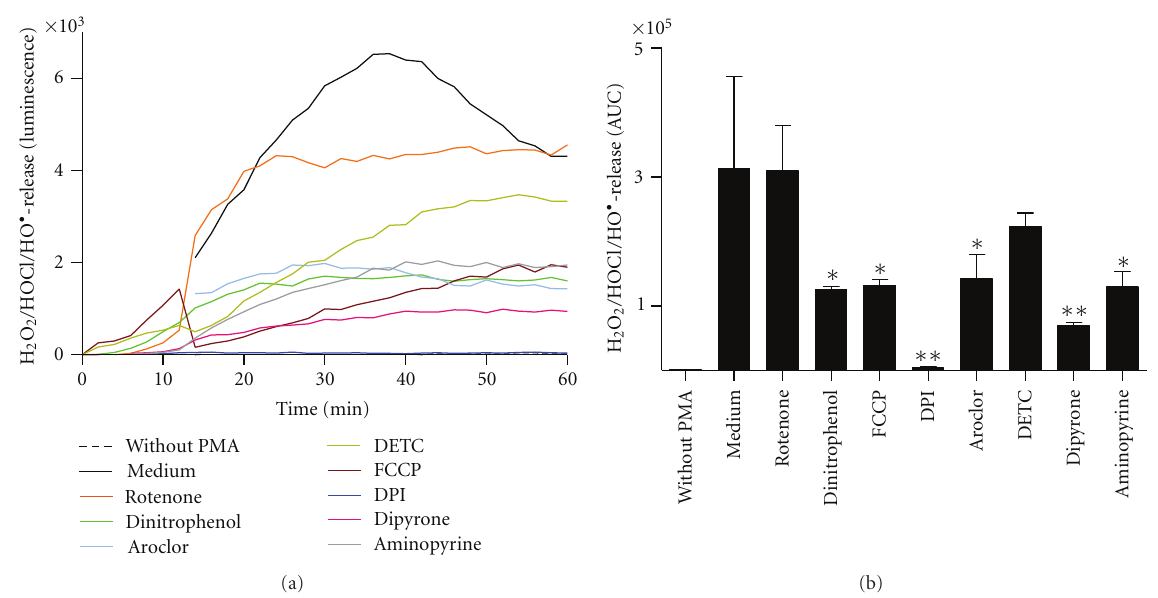
Figure 5: Assessment of intra- and extracellular ROS production of neutrophils after exposure to various inhibitors as measured by the luminol-amplified chemiluminescence assay. Freshly isolated human neutrophils were incubated with or without inhibitors (10 µ M Rotenone, 10 µ M Dinitrophenol, 500nM FCCP, 20 µ M DPI, 38 µ M Aroclor, 10 µ M DETC, 200 µ M Dipyrone, and 200 µ M Aminopyrine) for 30min at 37 ◦ C. Subsequently, luminol was added, and the ROS production was induced with 20 nM PMA. The H 2 O 2 release was detected by measuring chemiluminescence for a period of 1 h at 37 ◦ C. (a) Time kinetics of H 2 O 2 release (chemiluminescence) of one representative experiment. (b) H 2 O 2 release quantified by calculation of the area under the curve (AUC). Data show mean ± SD from three independent experiments, ∗∗ : P < 0 . 001; ∗ : P < 0 . 01 as compared to the PMA-stimulated sample without inhibitor